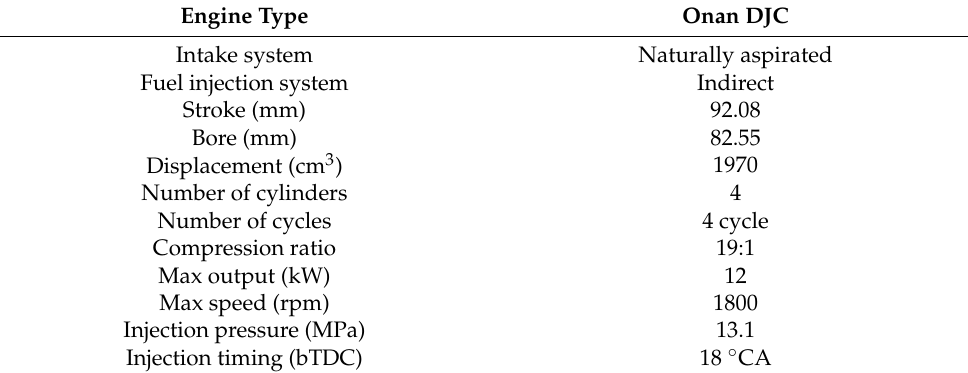
Table 1. Technical specifications of test engine.